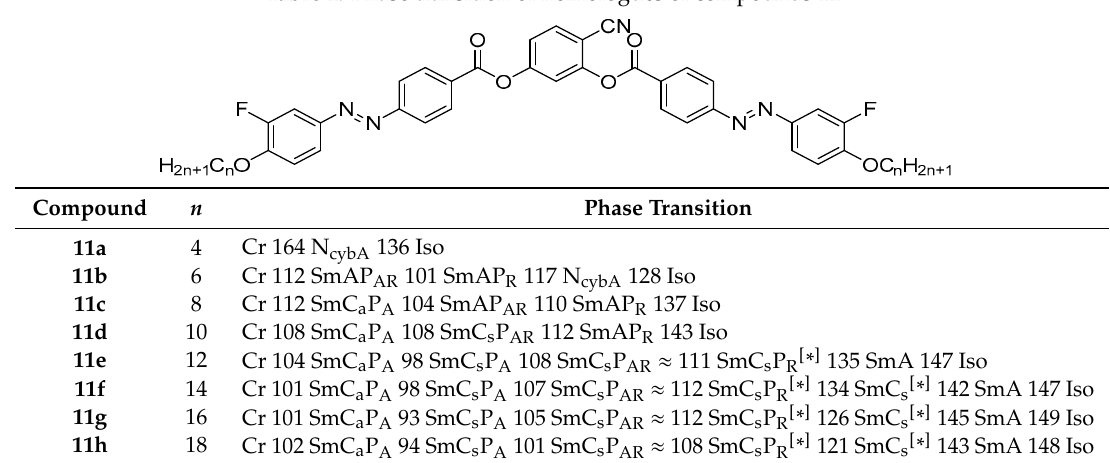
Table 1. Phase transition of homologues of compounds 11 .